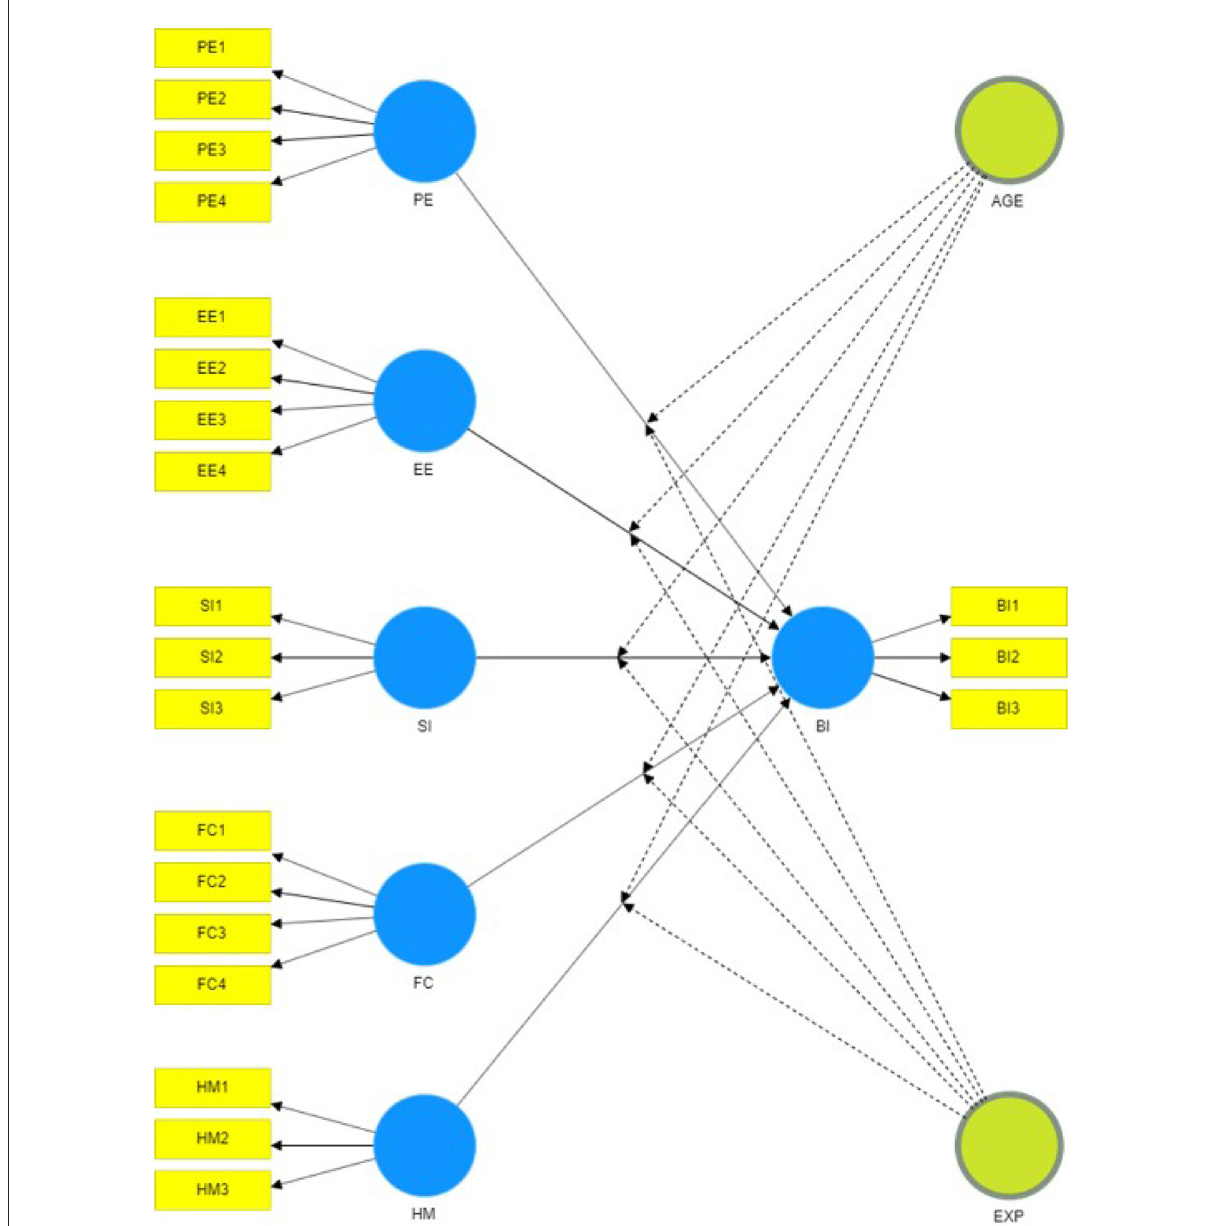
FIGURE3 Structural model including age and experience as moderator variables. The image has been adapted to show which relationships are expected to be affected by which moderating